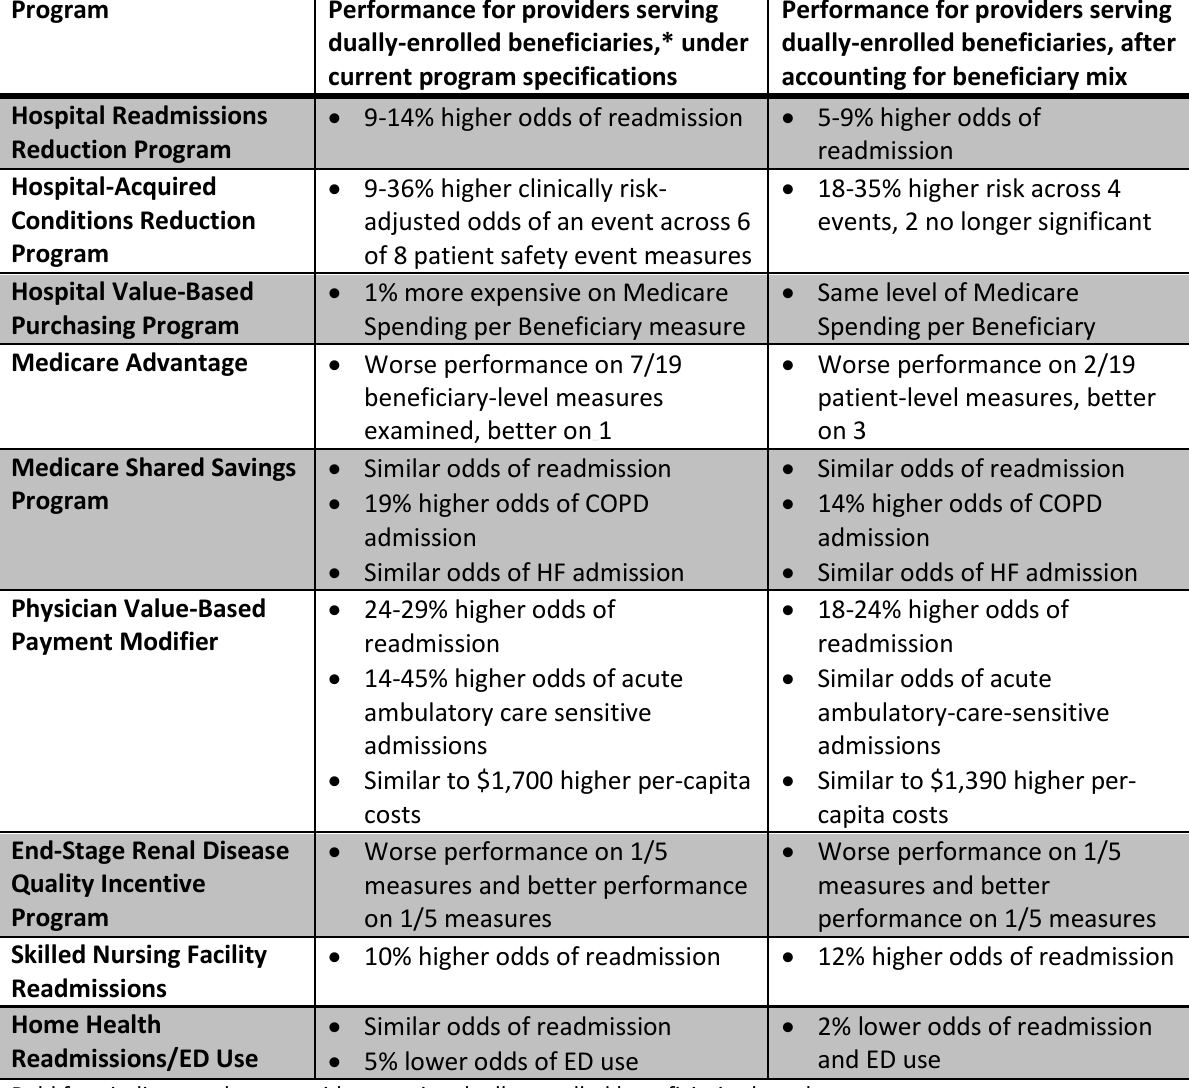
Table 14.2: Relationship Between Disproportionately Serving Dually-Enrolled Beneficiaries